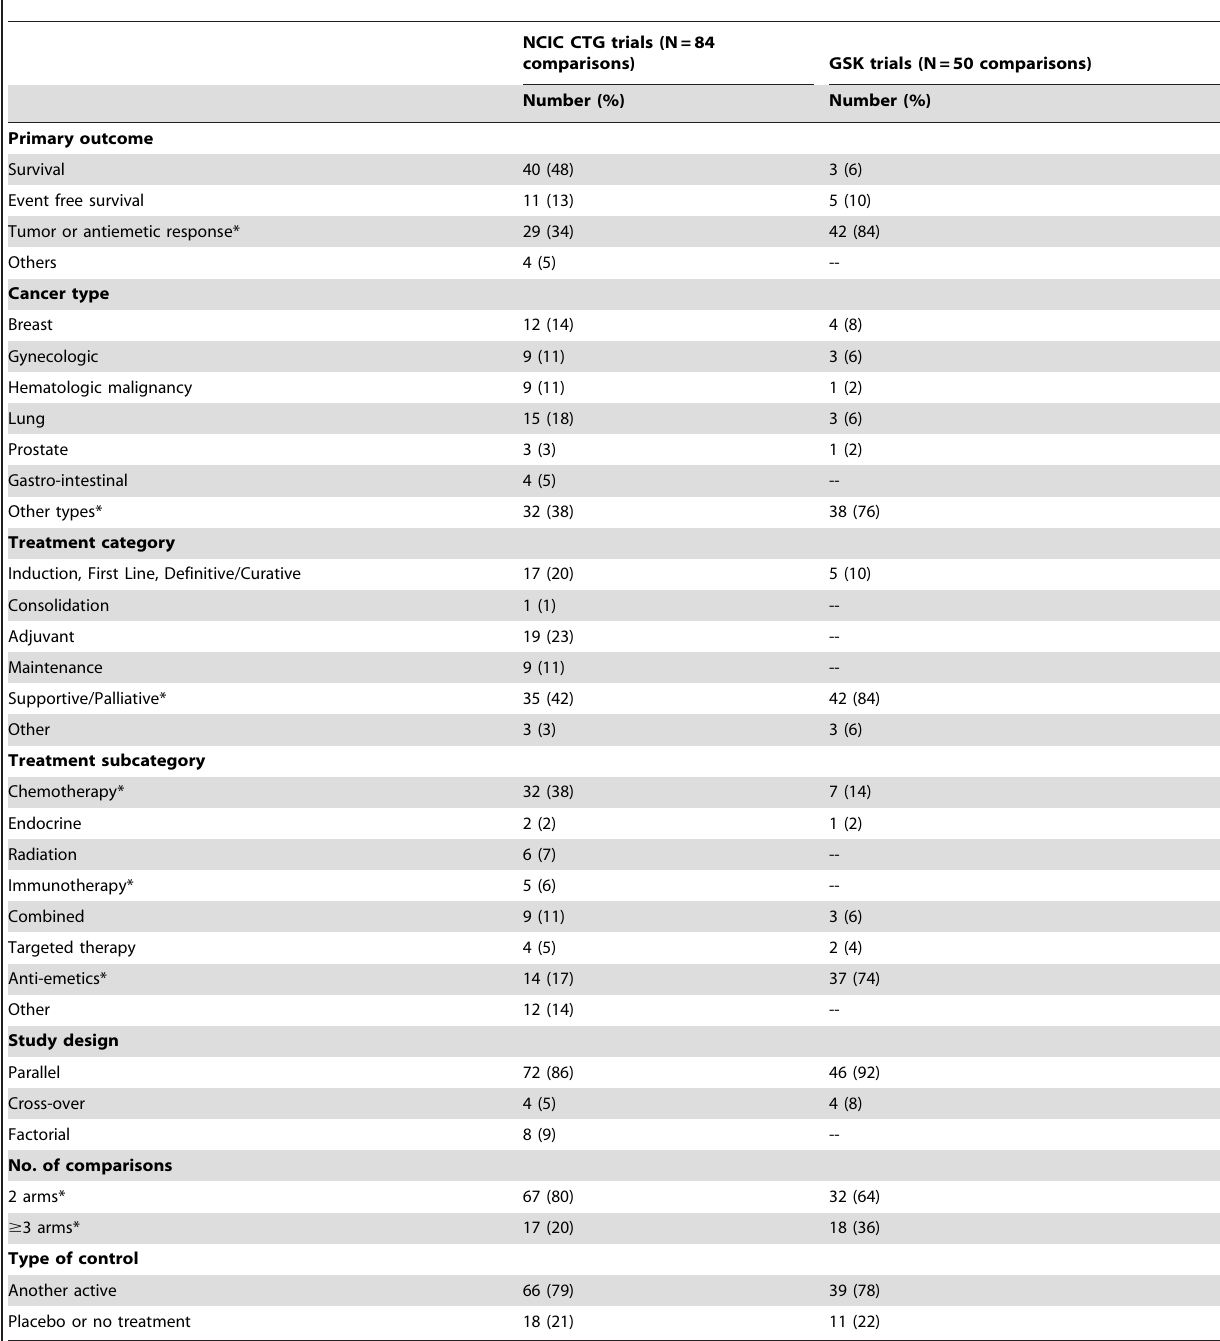
Table 1. Characteristics of included trials conducted by National Cancer Institute Canada Clinical Trials Group (CTG) and GlaxoSmithKline